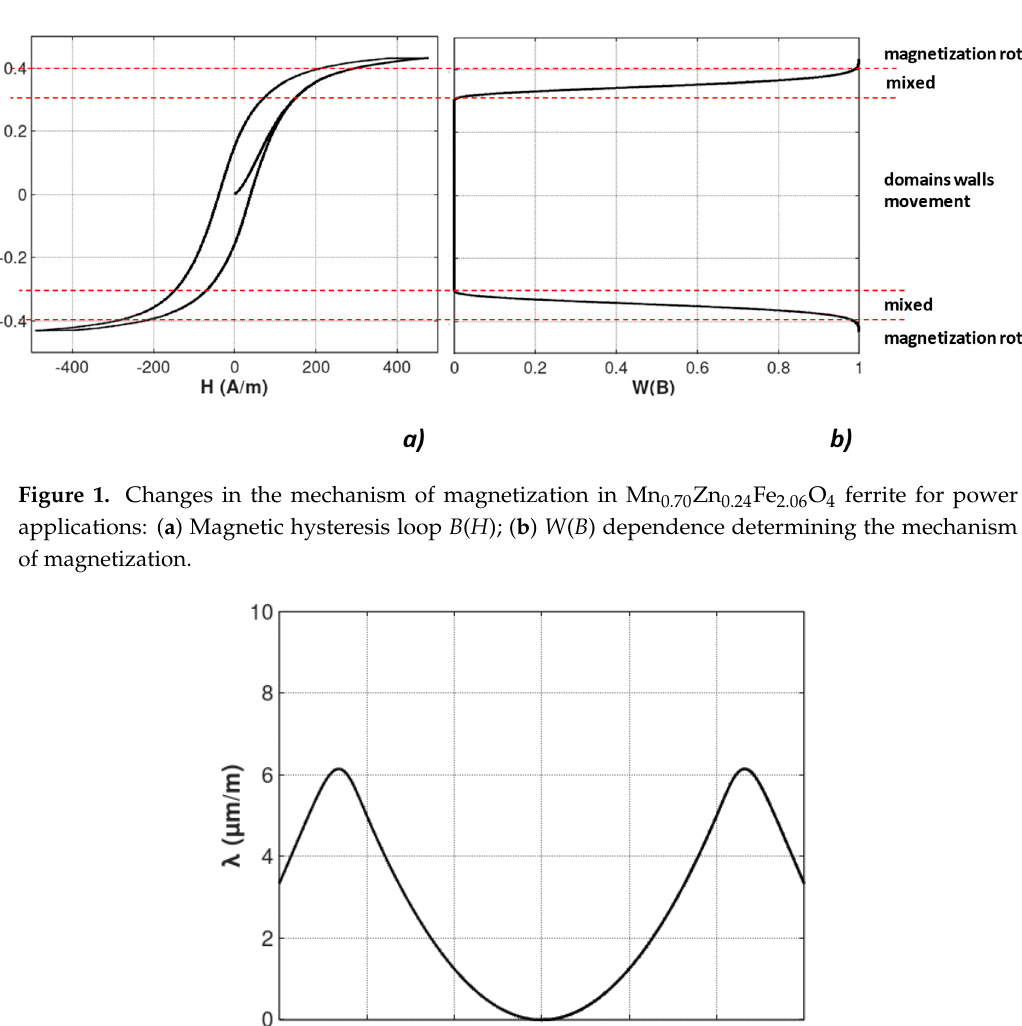
(cid:2869) (cid:2869) , a 2 = 10 (cid:2972)(cid:2923) , B switch = 1 T, k = 0.1. 1 1 , a 2 = 10 µ m , B switch = 1 T, k = (cid:2923) (cid:2904) (cid:3118) (cid:2923) (cid:2904) m m T T 2